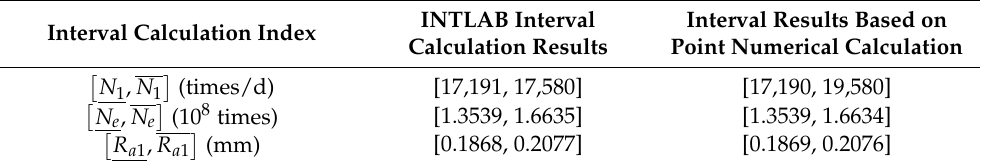
Table 3. Summary of interval results for different calculation